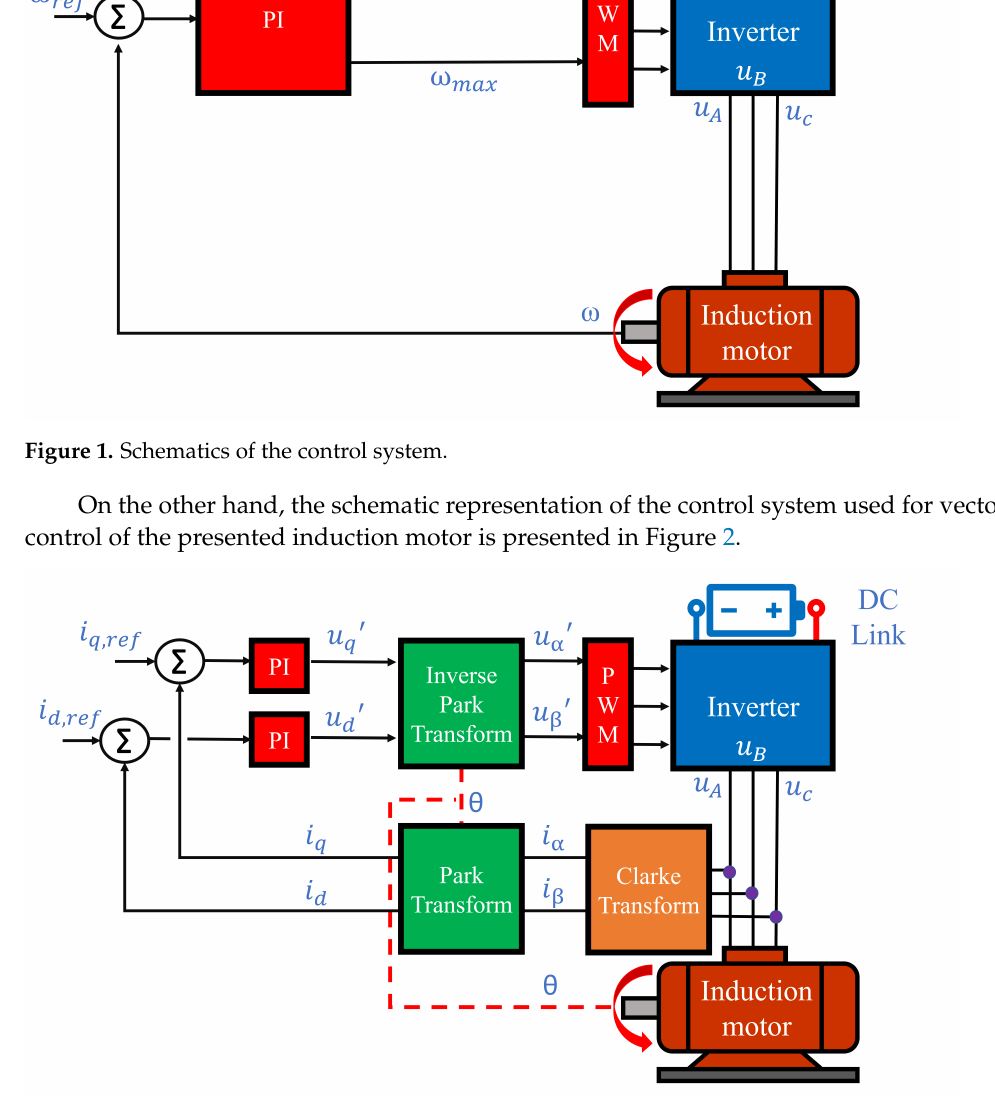
Figure 2. Schematics of the control system. A schematic representation of the used inverter topology is presented in Figure 3.